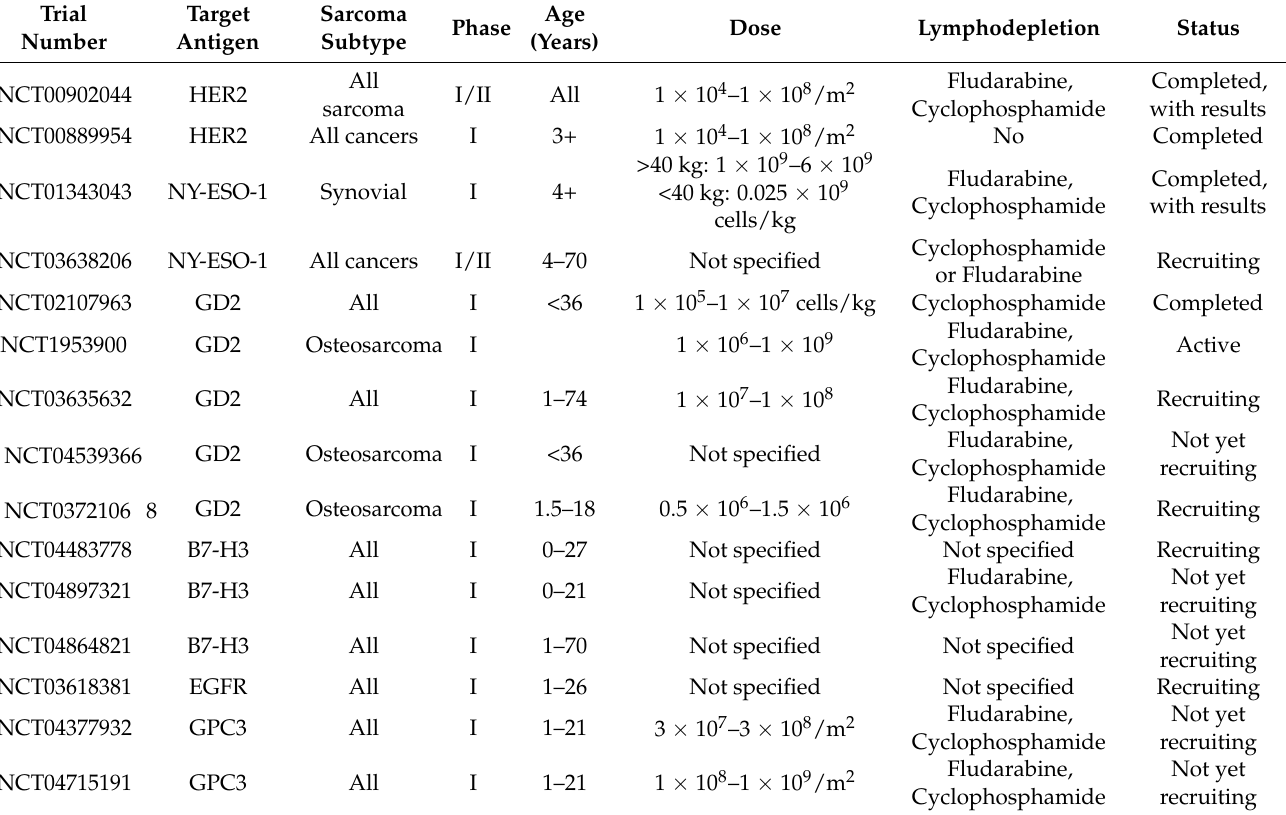
Table 1. CAR T cell clinical trials in pediatric